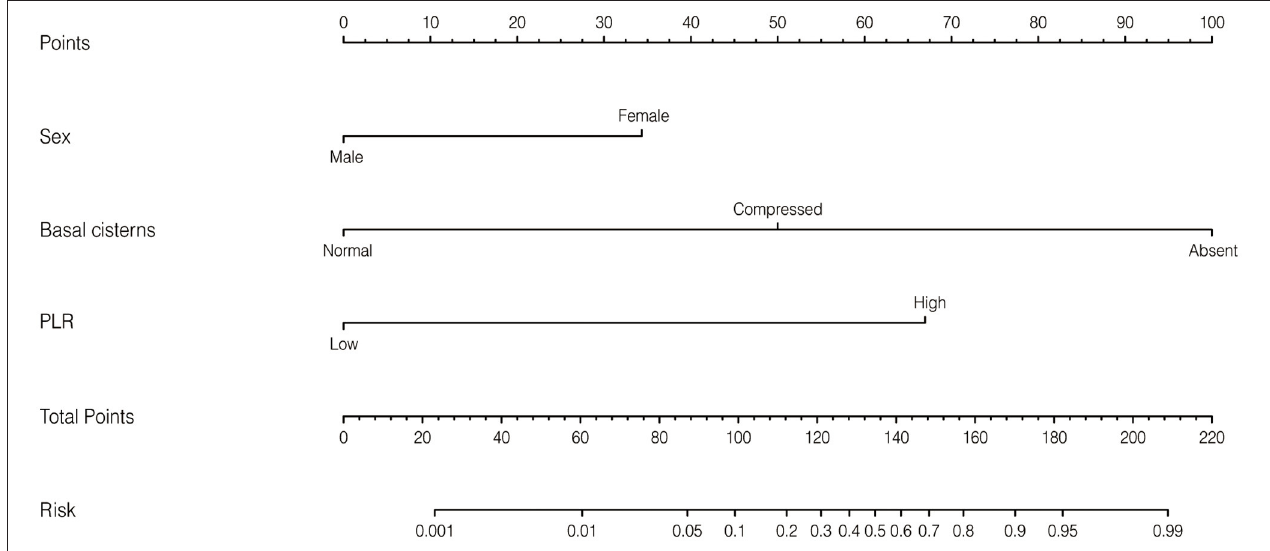
FIGURE 2 | Nomogram to predict early mortality in pediatric patients with moderate or severe traumatic brain injury (MS-TBI).